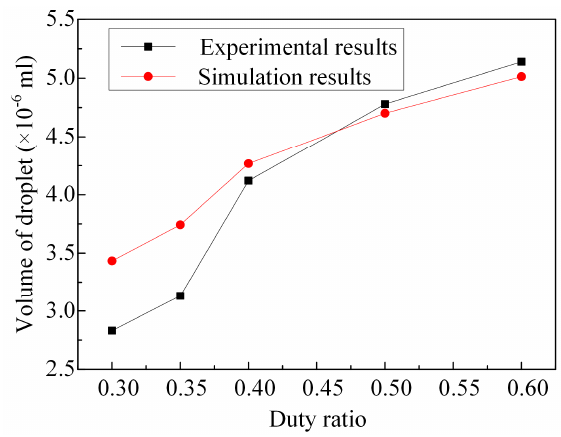
Figure 12. The droplet volume varies with different duty ratios.